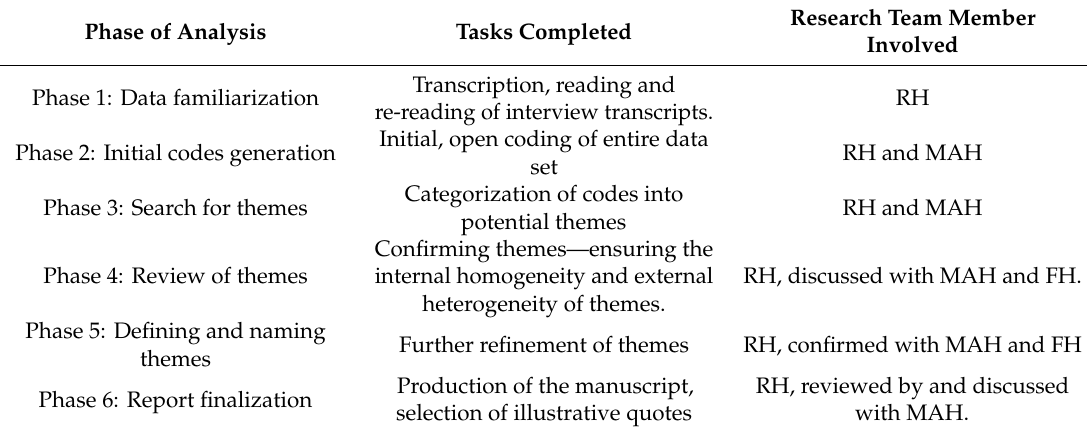
Table 2. Data analysis